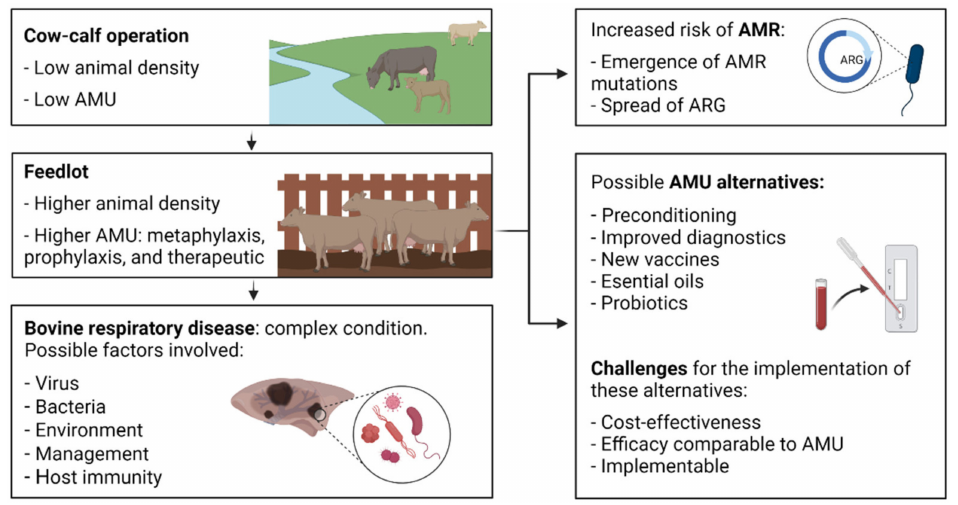
Figure 1. Possible predisposing factors and common management practices to control bovine respira- tory disease. AMU, antimicrobial use; ARG, antimicrobial resistance genes; BRD, bovine respiratory disease. Created with